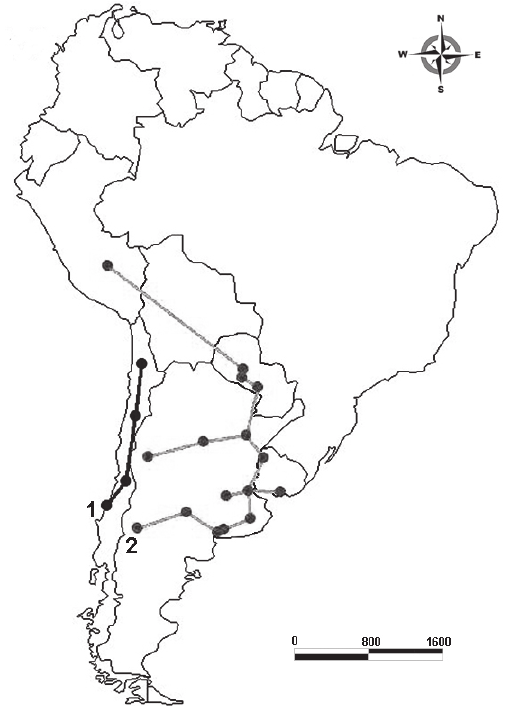
Fig. 15 - Individual track of Notiomastodon platensis